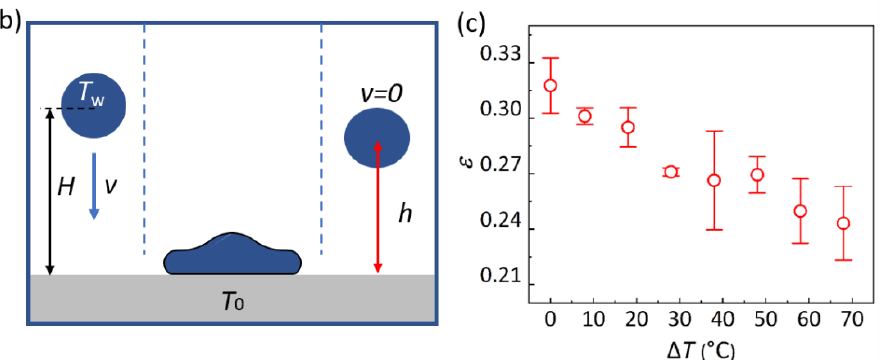
Figure 2. Hot-water droplets impacting on HWRS. ( a ) Snapshots showing droplets of 22 °C, 60 °C and 90 °C, respectively, impacting on the HWRS; ( b ) schematic of a hot-water droplet impacting on HWRS; ( c ) bouncing efficiency ε as a function of temperature difference Δ T = T w − T 0 between the droplet and the substrate.